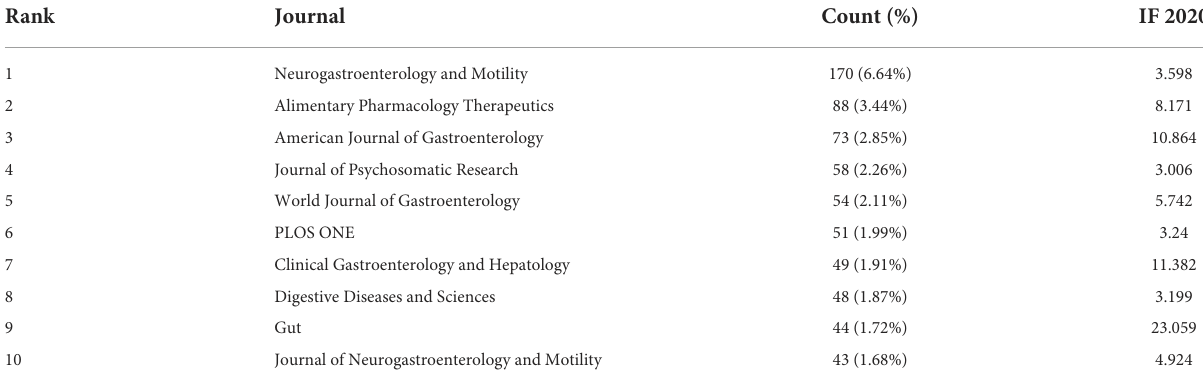
TABLE 3 Top 10 journals contributed to the